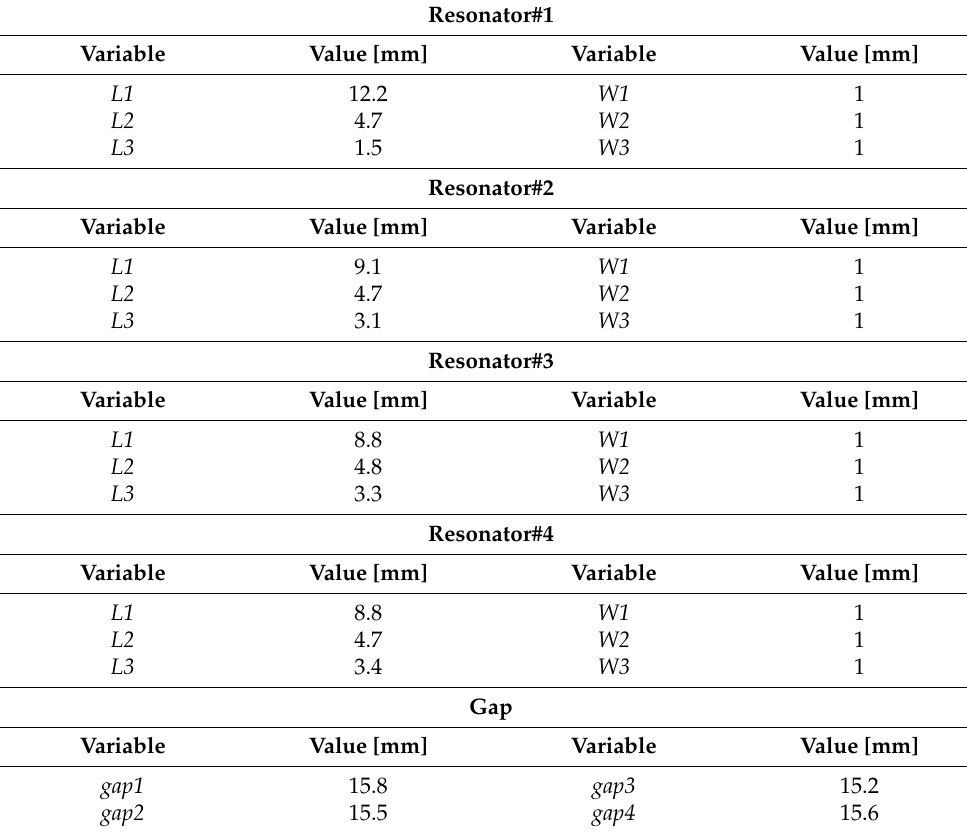
Table 6. The values of the physical dimensions of the eighth-order